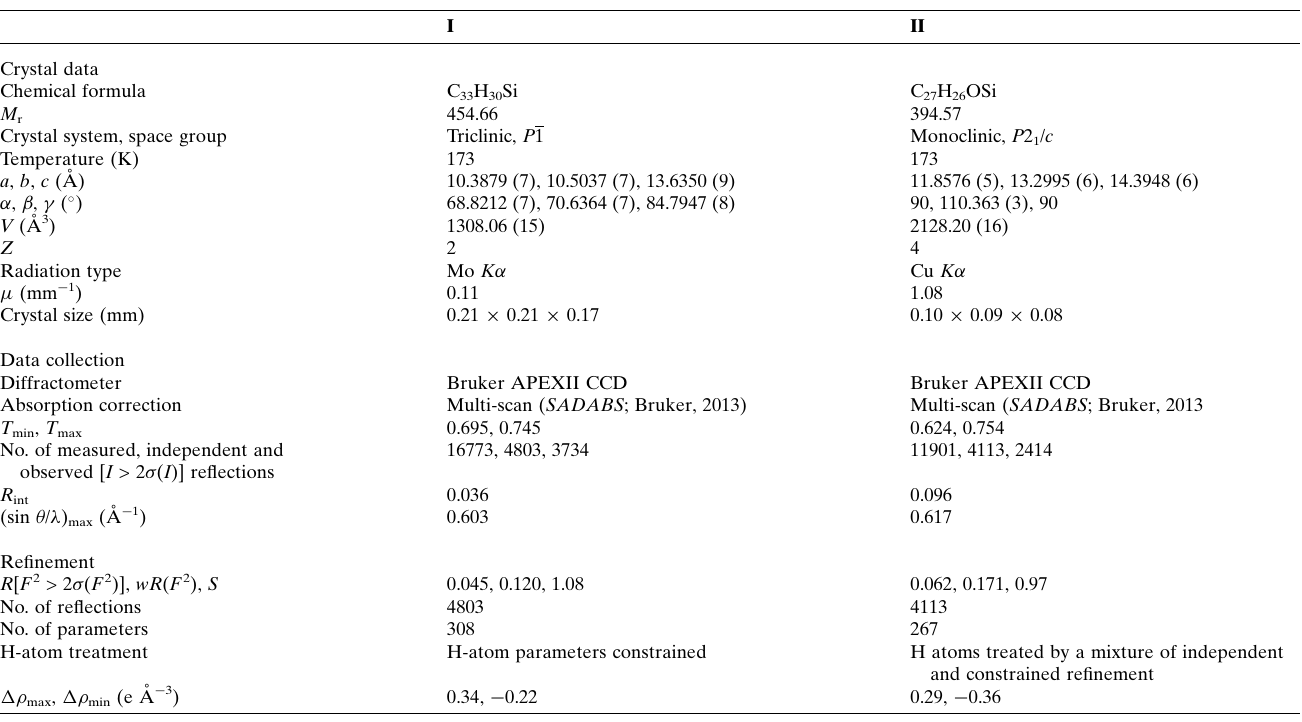
Table 3 Experimental details.